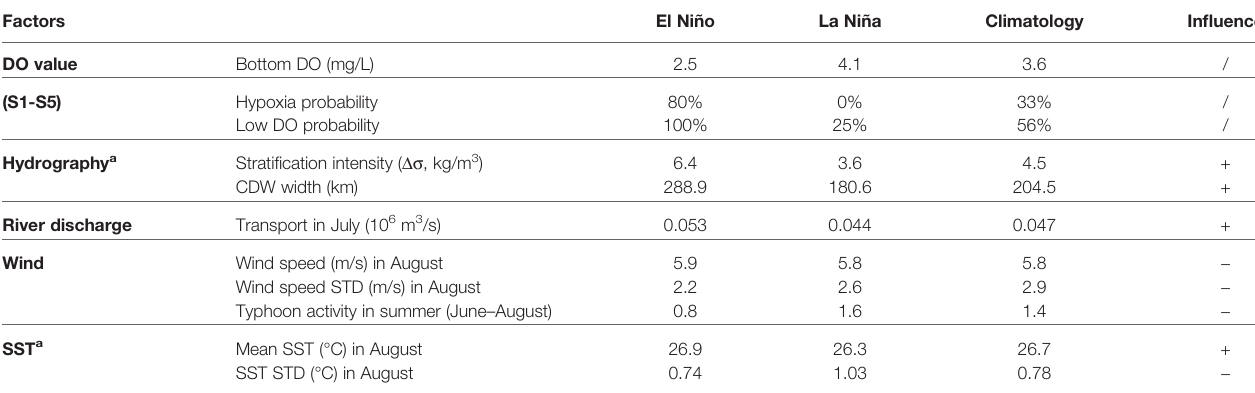
TABLE 2 | Indices for summer hypoxia and its associated multiple climate and oceanic factors along Section C-C during 1997 – 2014. Factors El Niño La